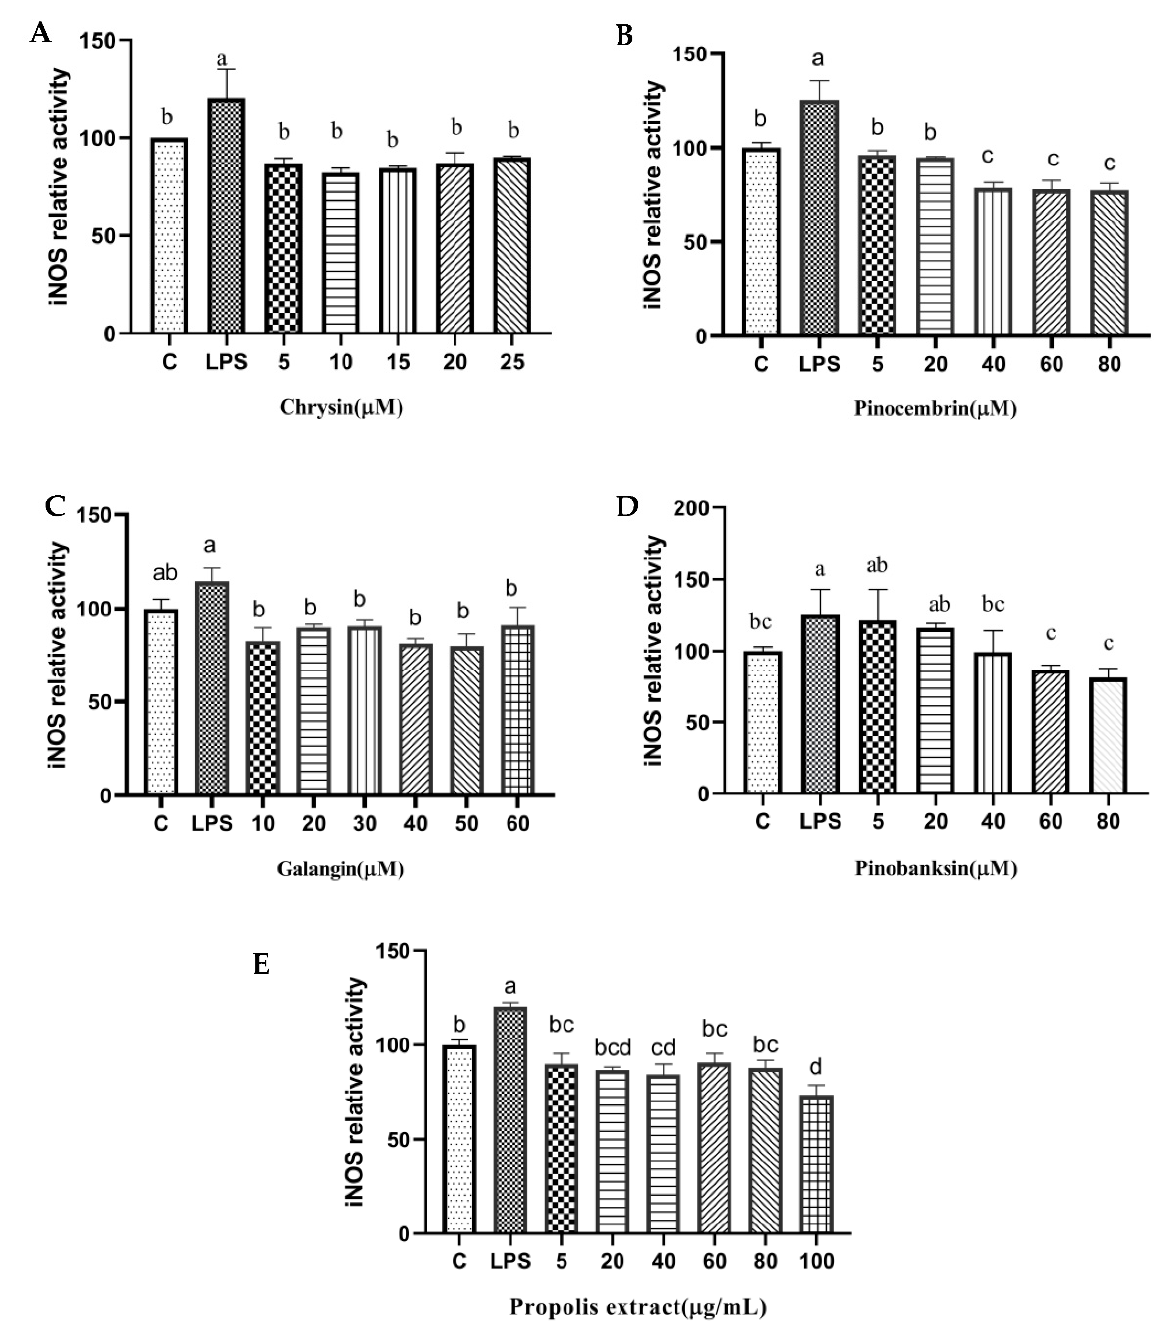
Figure 9. iNOS levels induced by individual flavonoids (chrysin, pinocembrin, galangin, and pinobanksin) and propolis extract in 10 µ g/mL LPS-induced H9c2 cells. H9c2 cells were stimulated with different concentrations of phytochemicals (chrysin, pinocembrin, galangin, pinobanksin, and propolis extract) for 12 h and then treated with 10 µ g/mL LPS for 12 h; finally, iNOS levels were detected with iNOS Assay Kit. ( A ) iNOS levels in chrysin-induced H9c2 cells. ( B ) iNOS levels in pinocembrin-induced H9c2 cells. ( C ) iNOS levels in galangin-induced H9c2 cells. ( D ) iNOS levels in pinobanksin-induced H9c2 cells. ( E ) iNOS levels in propolis-extract-induced H9c2 cells. Values are expressed as the mean ± SEM ( n = 3). Values with different letters (a, b, c, d) in the figure showed significant differences at p <